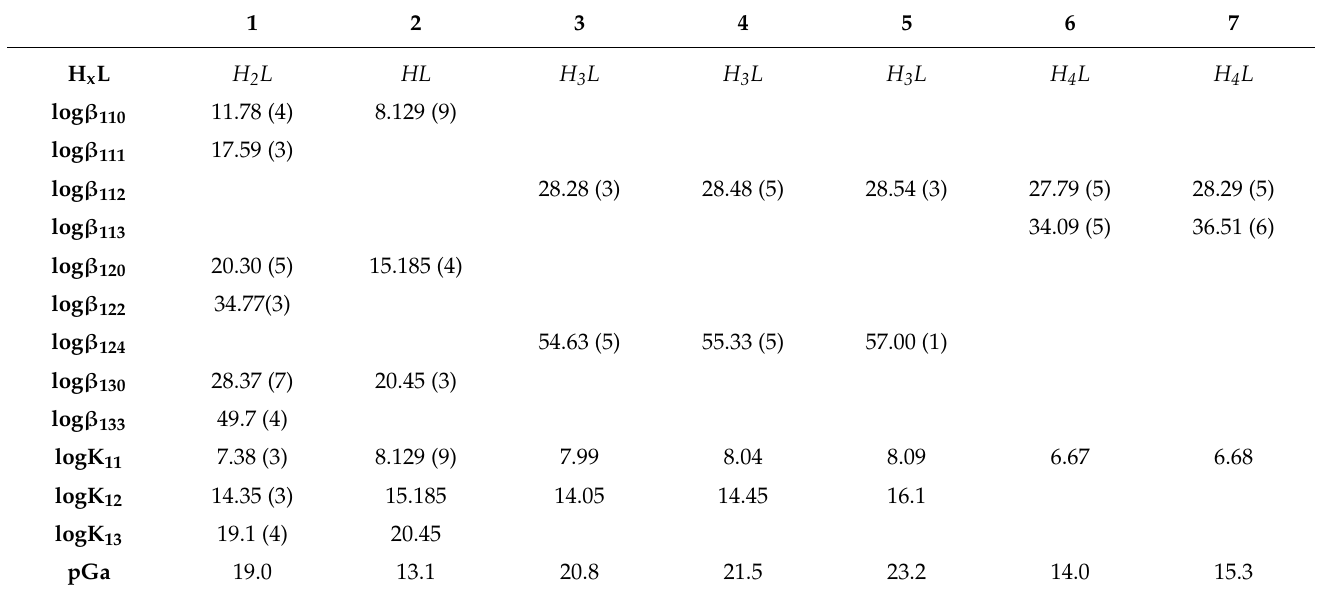
Table 3. Overall stability constants ( β ) and apparent formation constants (K) calculated from spec- trophotometric data at 298 K using HypSpec software [36]. LogK values were estimated starting from the log β MLH ones according to the different number of acid groups as follows: (HL) logK 11 = log β 110 , logK 12 = log β 120 , logK 13 = log β 130 ; (H 2 L) logK 11 = log β 111 − log β 11 , logK 12 = log β 122 − 2log β 11 , logK 13 = log β 133 − 3log β 11 ; (H 3 L) logK 11 = log β 112 − log β 12 , logK 12 = log β 124 − 2log β 12 ; (H 4 L) logK 11 = log β 112 − log β 12 ; pGa ( − log[Ga 3+ ] free ) was calculated at specific conditions ([Ga 3+ ] total = 1 μ M, [L] total = 10 μ M, pH 7.4 at 25 °C).